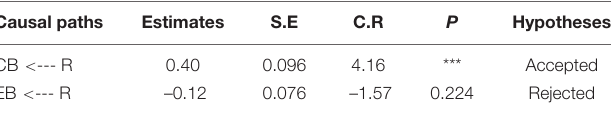
TABLE 2 | Structural equation modeling (SEM) regression weights (standardized estimations).